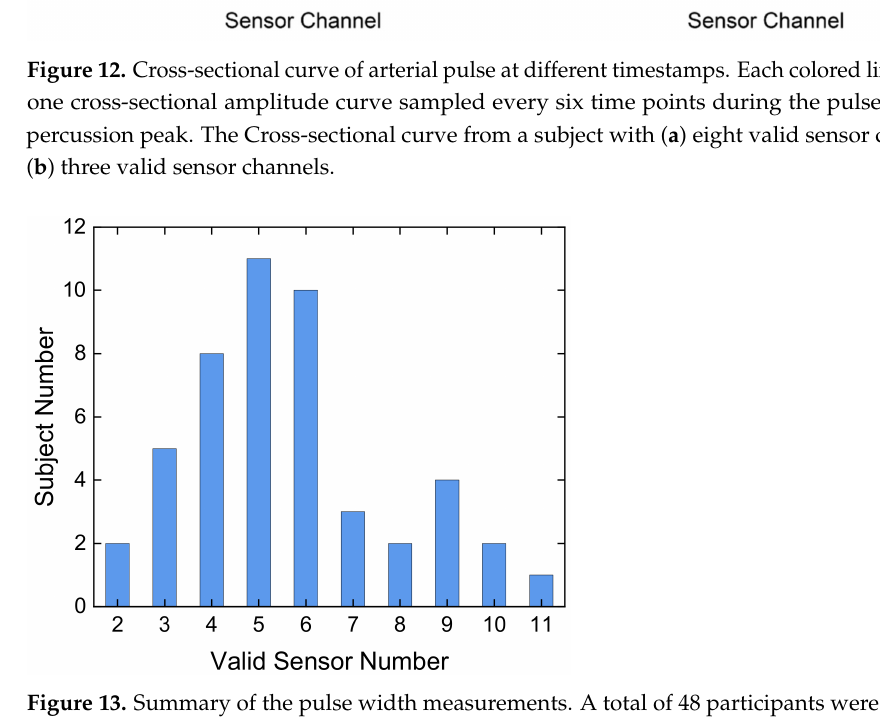
Area of the shadow parts D s = Area under the green curve